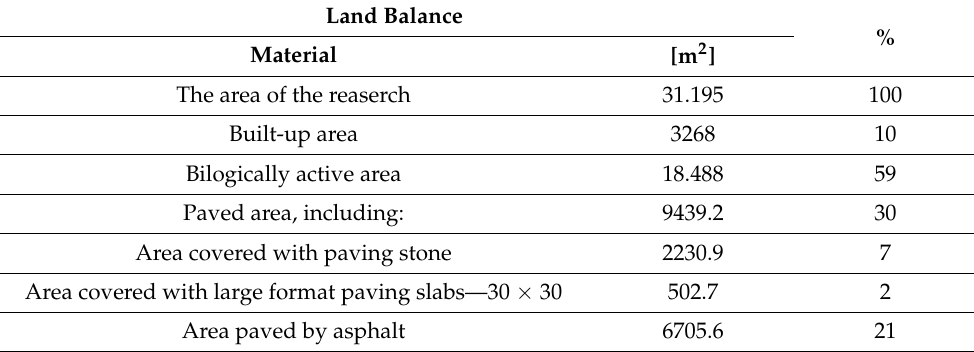
Table 2. Summary of pavements in the study area.